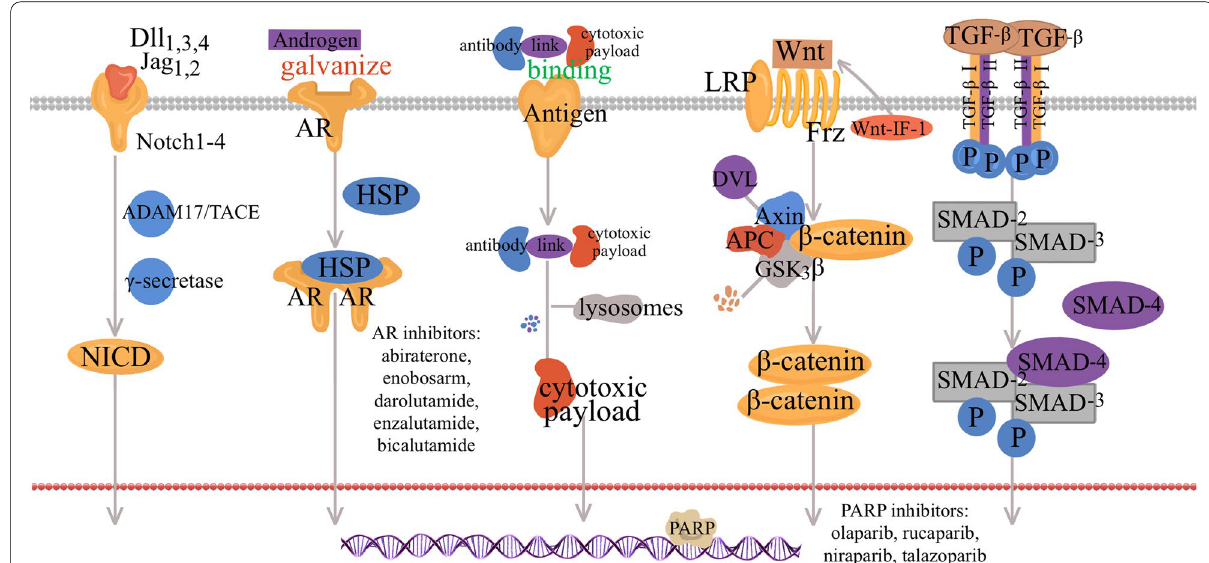
Fig. 3 Partial Signaling pathways and potential targets for the treatment of TNBC. PARP is a DNA repair enzyme, which can promote the repair of single strand DNA breaks. PARP inhibitors can suppress DNA repair resulting in cytotoxicity. Notch receptors (Notch 1–4) on the surface of one cell bind to ligands ( Dll 1, 3, 4, and JAG 1, 2), thus activate Notching pathways. The Notch ligand–receptor complex is hydrolyzed by the ADAM17/TACE metalloprotease and γ-secretase in turn, releasing the intracellular domain of Notch into the nucleus. AR bind to endogenous androgens, and then form a homodimer. Before homodimer, AR is bound to HSP. Subsequently, the homodimer moves into to the nucleus and activates target gene transcription, regulating cell proliferation. ADCs consist of a highly efficient cytotoxic payload, an antibody and a linker connecting the former two components. ADC binds to target antigens on tumor cell surface and then enter the target cell via receptor-mediated endocytosis. After entering the cell, ADCs are degraded by lysosomes, in which the linker cleaves, leading to the release of payloads into cytoplasm. When the Wnt signaling is on, Wnt/β-catenin signaling pathway is activated from the combination of lipid-modified Wnts and the receptor complex which is composed of Fzds and LRP5/6. Dvl inhibit the destruction complex, inhibiting the β-catenin proteasomal degradation. therefore, the β-catenin enter into the nucleus. After entering into the nucleus, β-catenin binds to T cell factor and LEF families and regulates Wnt target gene expression. When Wnt ligands are absent in the cytoplasm, β-catenin is sequestered by the destruction complex (APC, GSK-3β and CK1α), and then phosphorylated by CK1α and GSK-3β in turn. TGF-β is excreted by cells and then successively binds to TβRII and TβRI on the surface of cell. During this process, two TβRI and two TβRII molecules form a heterotetrametric complex, further causing the phosphorylation and activation of TβRI. After that, the activated complex phosphorylates Smad2 and Smad3 in sequence, which bind to SMAD4 to form SMAD trimer complex. Finally, the complex translocates into nuclei and promotes target gene